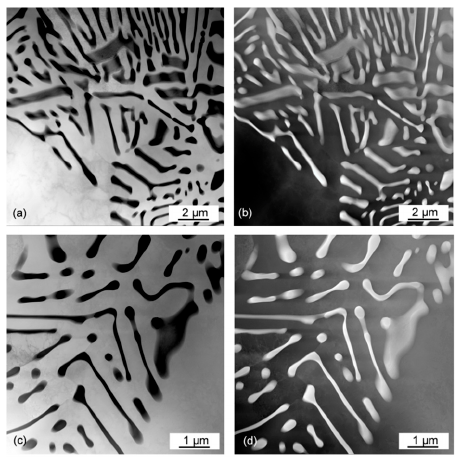
Figure 9. Morphology of the Al 11 Ce 3 eutectic phase in the Al–5Ce alloy imaged by STEM: ( a ) bright field image showing the eutectic colony along with proeutectic ferrite; ( b ) HAADF image; ( c ) bright field magnified view showing a mixture of the presence of regular lamellae, rods and L-shape plates; and ( d ) HAADF image.